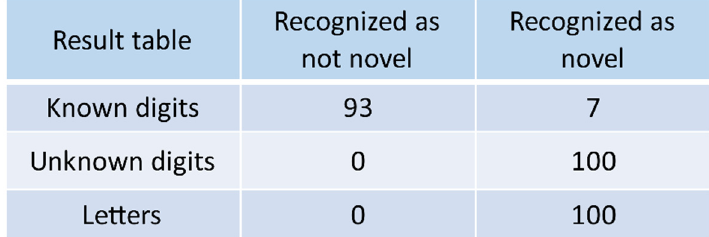
Figure 12. Performance of applying the fully semantic novelty detection.